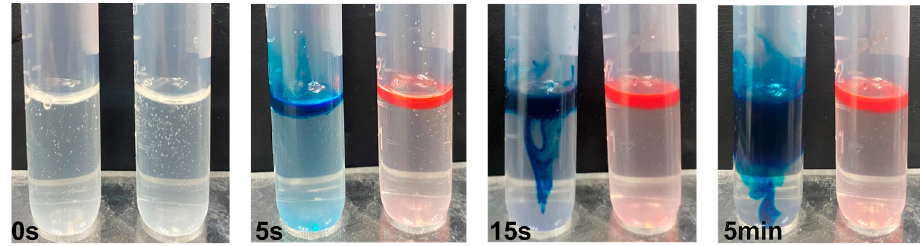
Figure 3. Diffusion process of two different dyestuffs in Nano-Thy. Blue and red indicated methylene blue and Sudan III, respectively.